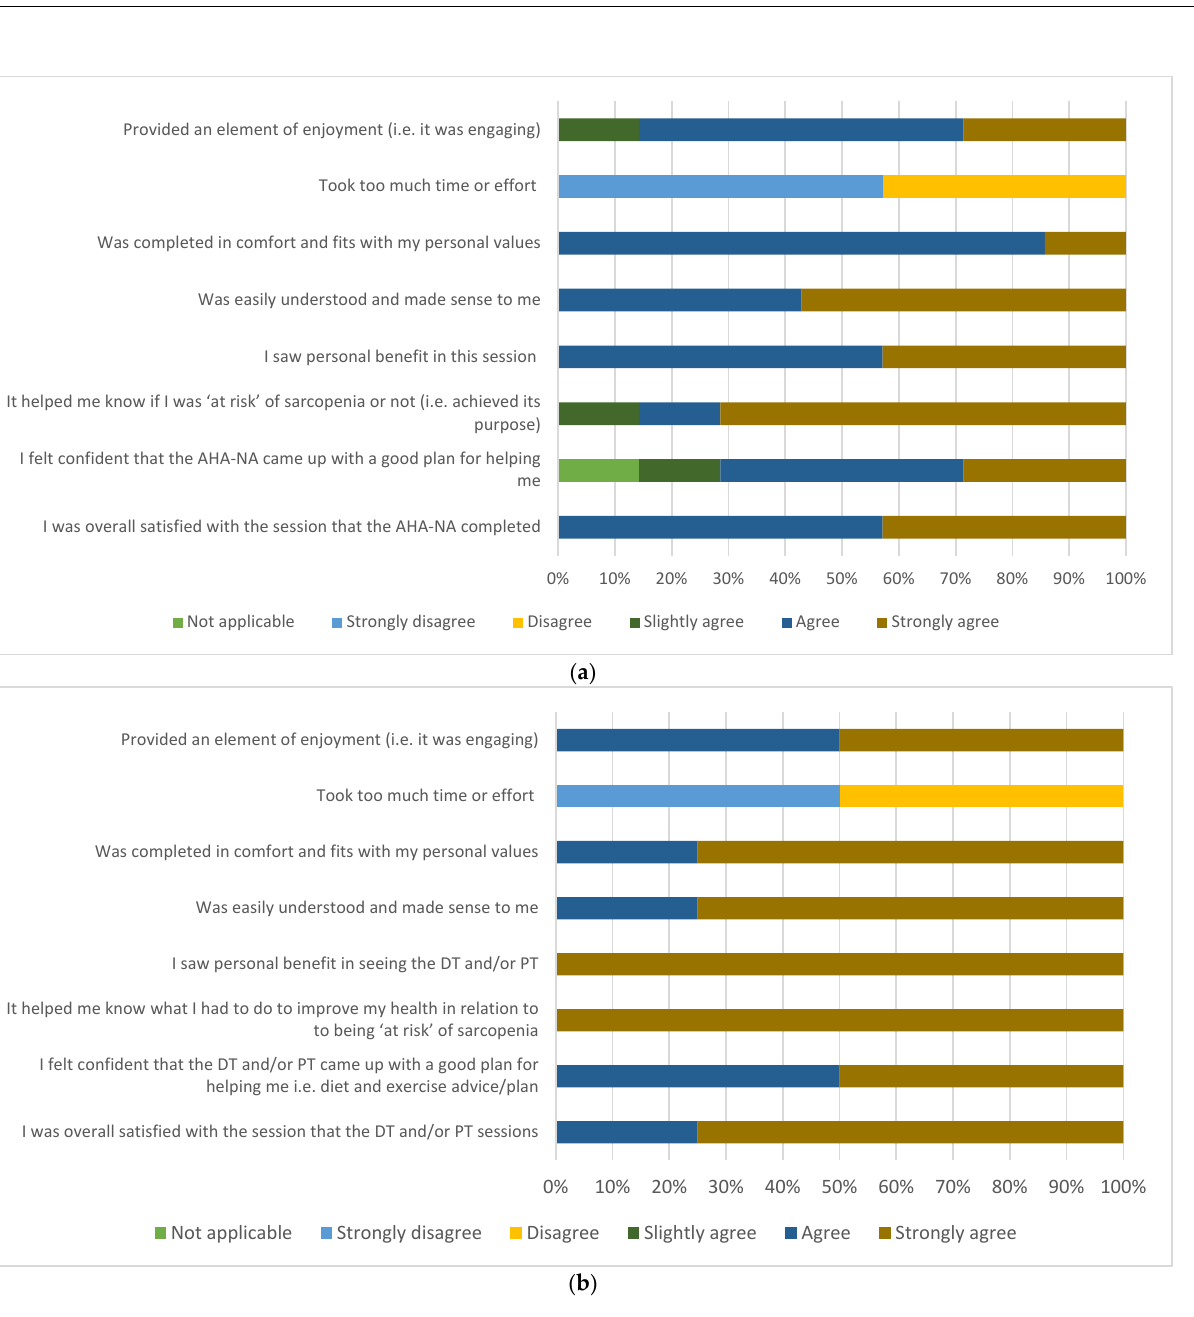
Figure 3. ( a ) Participant acceptability of the AHA-NA care on the sarc-pathway ( n = 7); ( b ) participant acceptability of the dietitian and physiotherapist care on the sarc-pathway ( n = 4). Abbreviations: AHA-NA = allied health assistant–nutrition assistant; DT = dietitian; PT = physiotherapist.